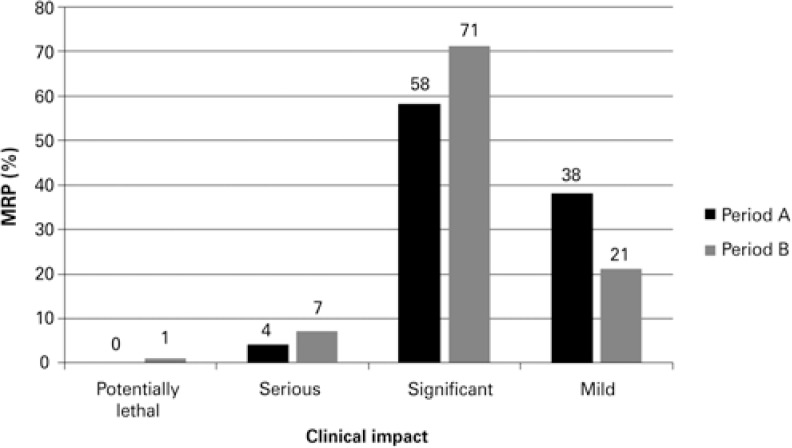
Clinical impact of medication-related problemsMRP: medication-related problem.